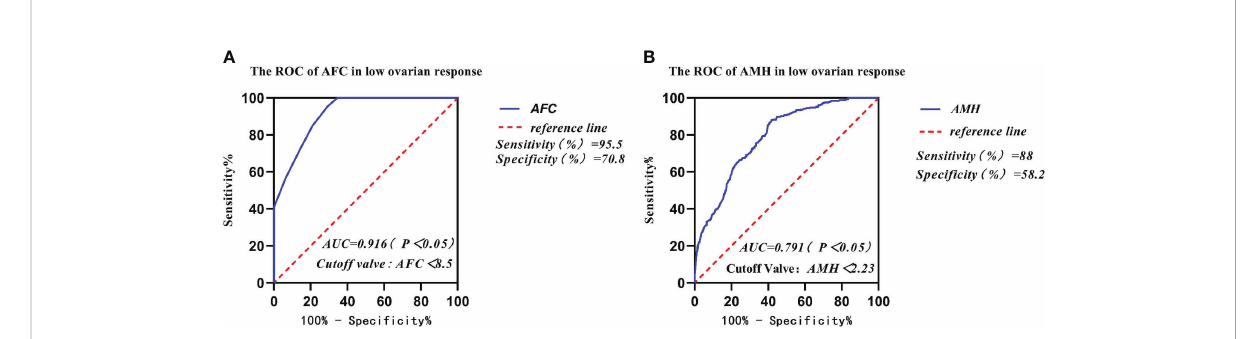
FIGURE 2 Comparison of prediction performance of Retrieved oocytes vs AFC, AMH, BMI, and age in the group of low ovarian response. (A) The ROC of AFC in low ovarian response; (B) The ROC of AMH in low ovarian response.